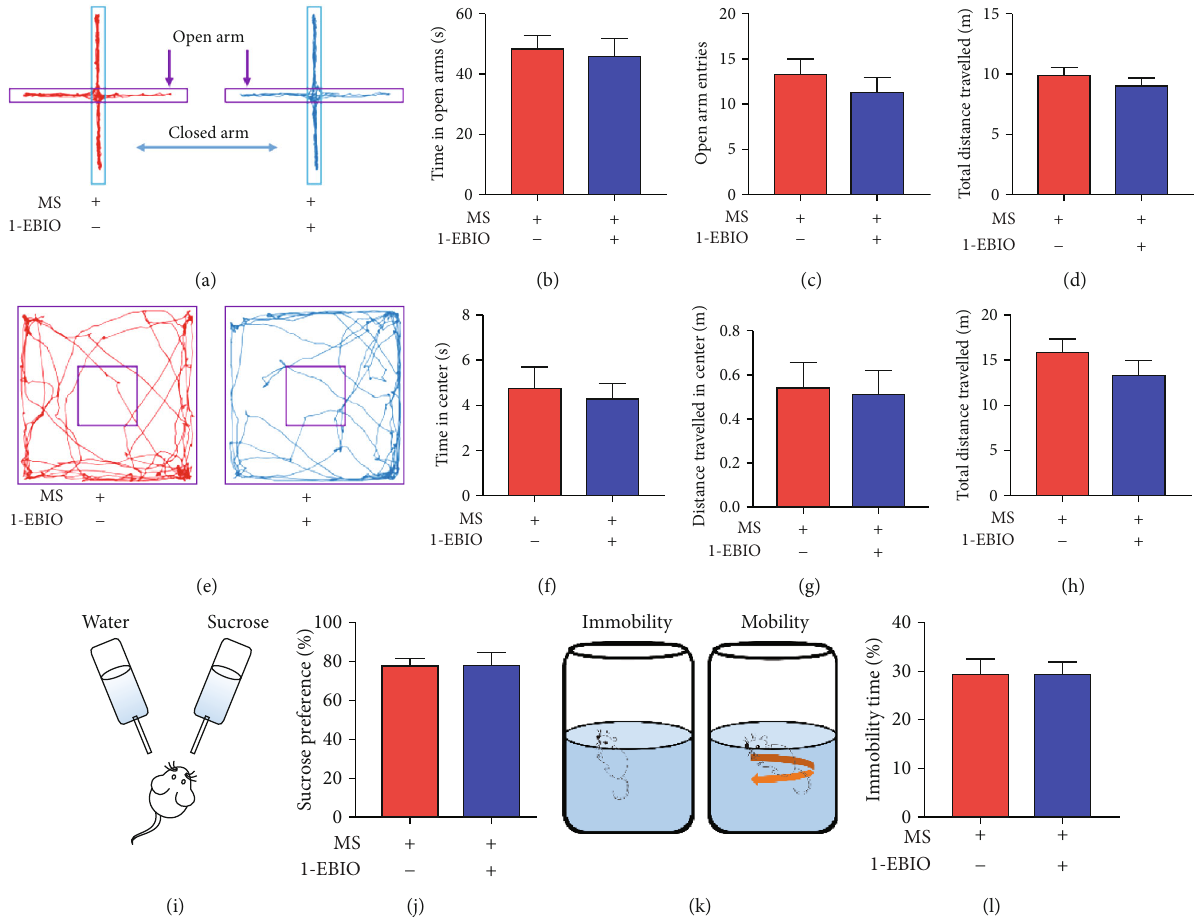
Figure 7: E ff ects of SK2 activator 1-EBIO on anxiety- and depression-like behaviors. (a) Representative activity traces of control mice and mice with 1-EBIO injection in the elevated plus maze. (b – d) There was an insigni fi cant di ff erence in the duration spent in the open arms ( t -test, t = 0 : 35 , P = 0 : 735 ), the times of entry into the open arms ( t -test, t = 0 : 82 , P = 0 : 425 ), and the total distances travelled ( t -test, t = 0 : 99 , P = 0 : 343 ) between the two groups ( n = 8 per group). (e) Schema of the open fi eld and the representative activity traces during an open fi eld test in control mice and mice with 1-EBIO injection. (f – h) There was an insigni fi cant di ff erence in the duration in central